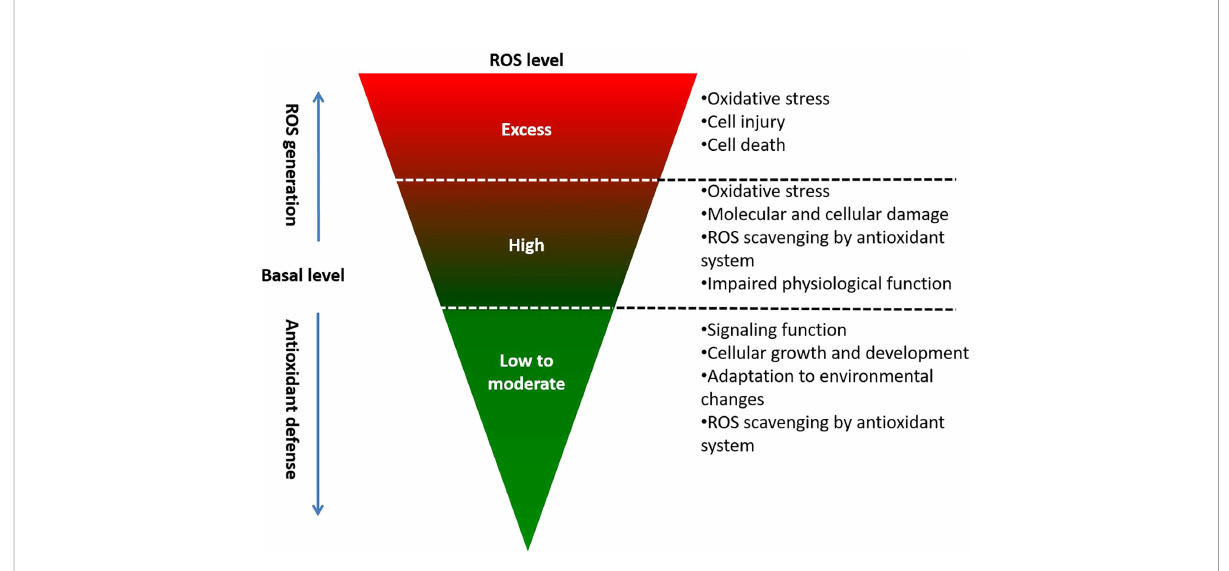
FIGURE 4 REDOX homeostasis and effect of various ROS levels on plant cellular